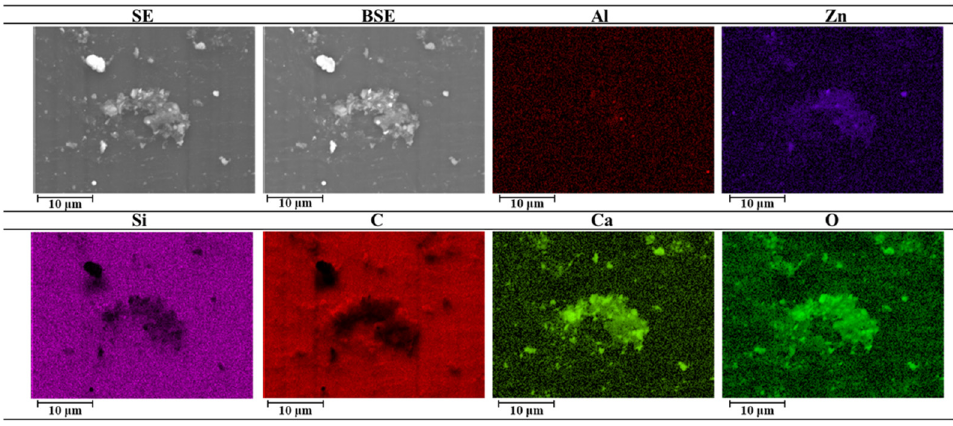
Figure 18. EDX analysis results for a-C:H:Si-coated journal.